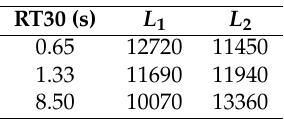
Figure 14. Delay line length curves measured in the strongly reverberant (RT30 of 8.50 seconds, solid curves) and weakly reverberant environment (RT30 of 0.65 seconds, dot curves), using the ( a ) proportional ( L 1 ) and ( b ) reflected ( L 2 ) mappings. Table 4. Comparison of the reverberant characteristics (RT30) and the average delay line lengths during the first 5 minutes, using the proportional ( L 1 ) and reflected ( L 2 ) mappings.